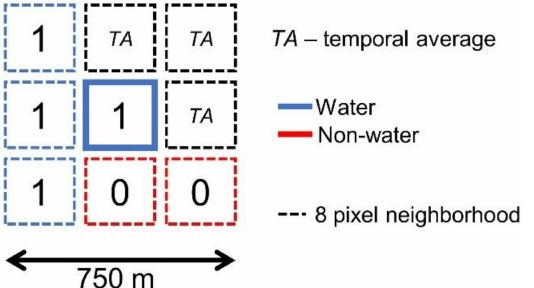
Figure 6. Spatiotemporal relations based on neighborhood pixels. Here, three observations are invalid and therefore substituted by temporal averages